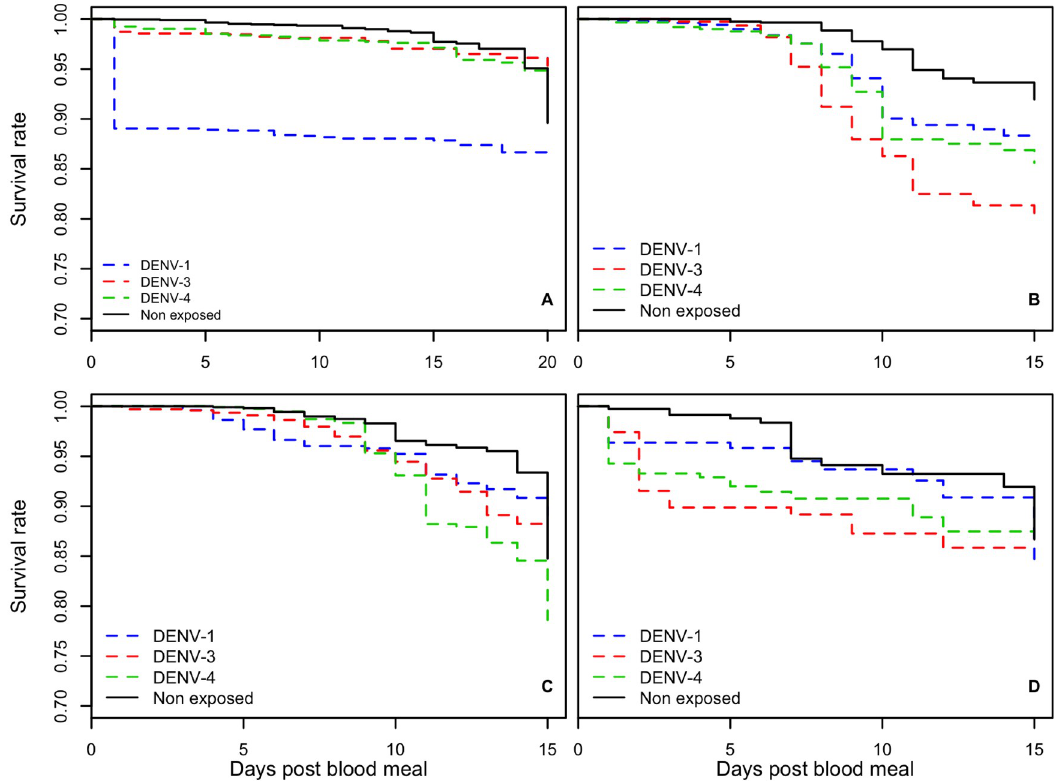
Fig 4. Daily changes in survival after exposure of Ae . aegypti populations from Dakar (A), from St. Louis (B) and from Kedougou (C) and Aedes taylori (D) to infected blood meals with dengue viruses 1, 3 and 4 and uninfected blood used as control (Non